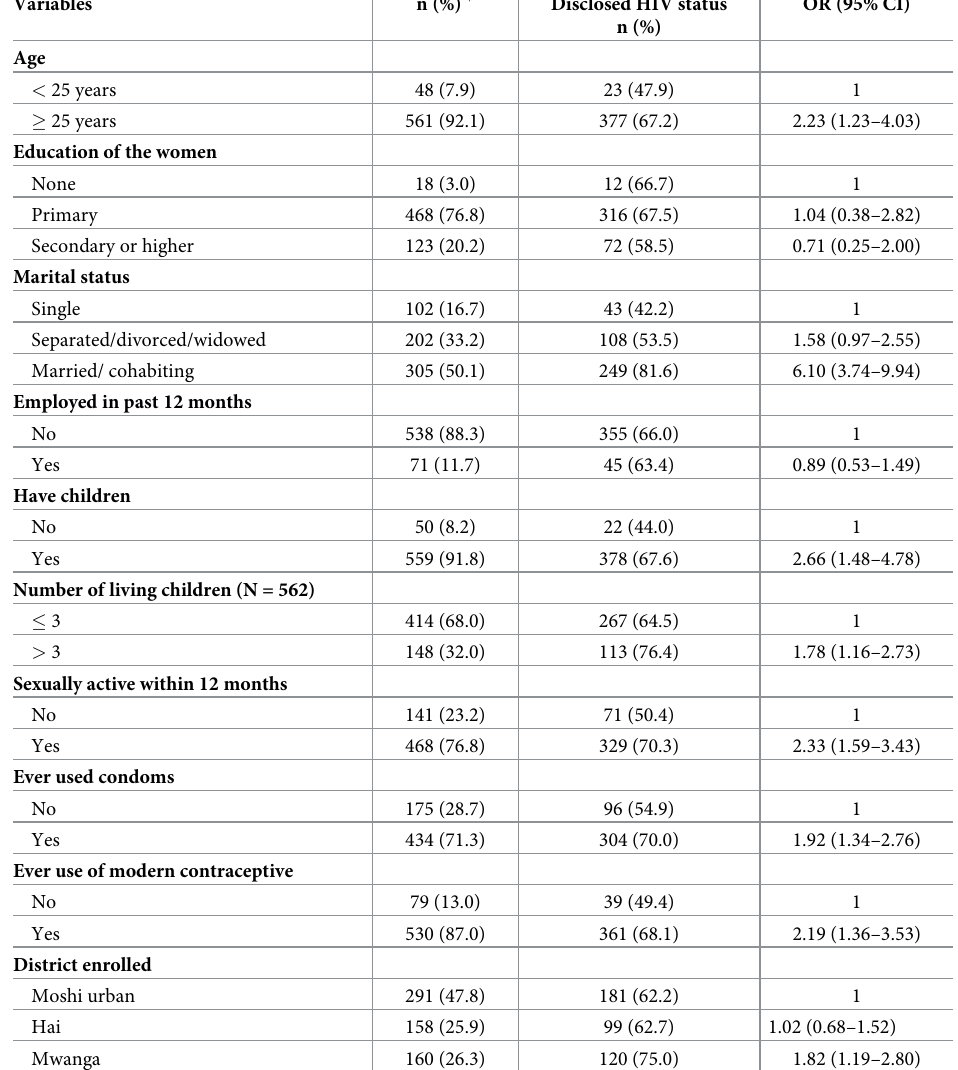
Table 1. Demographic and reproductive health characteristic associated with HIV-status disclosure in Kiliman- jaro (N = 609).